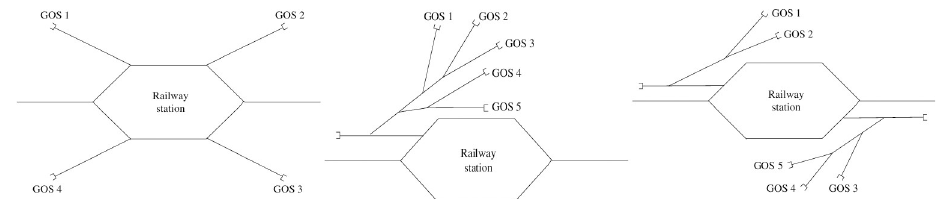
Fig 1. Layout of GOS in railway stations. (a) Radial-shaped Station, (b) Branch-shaped Station, (c) Mixed-shaped Station.